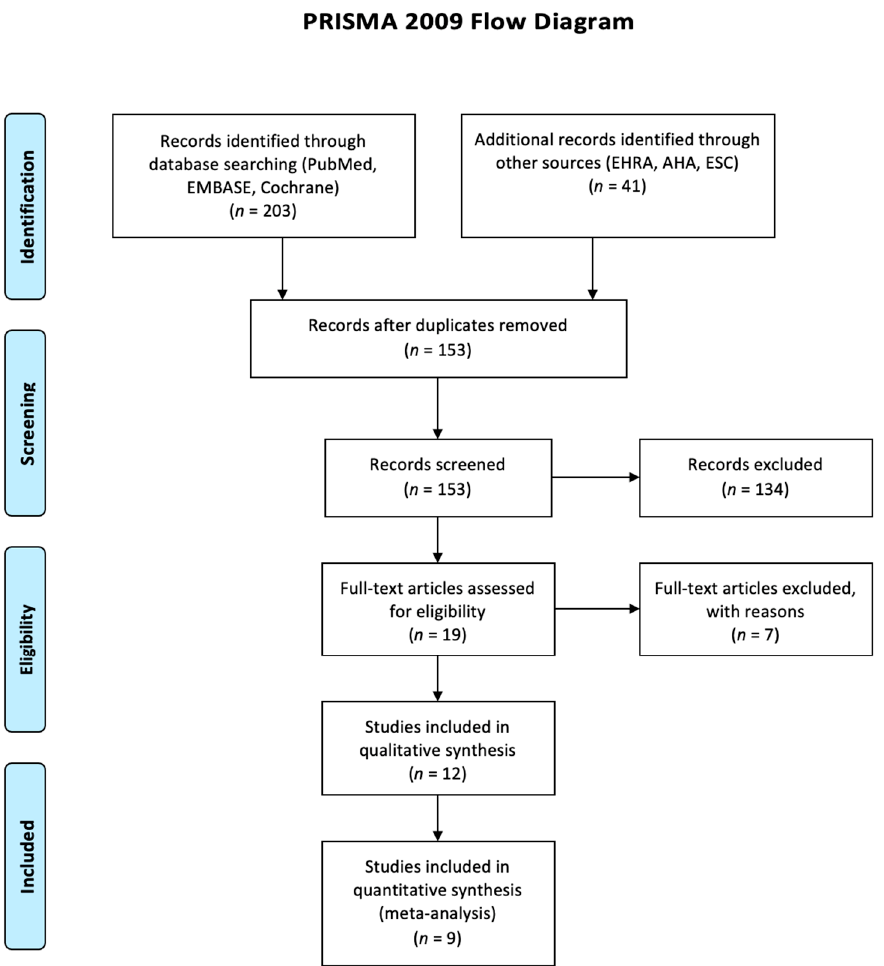
Figure 1. PRISMA flow diagram of study selection.